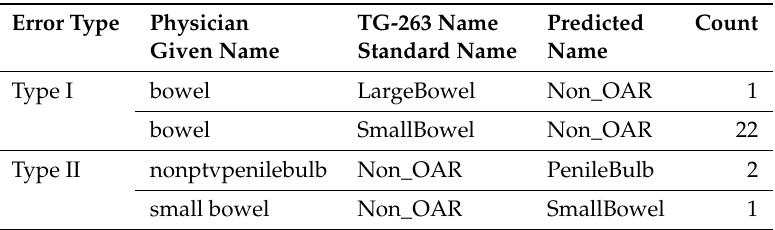
Table 6. Error analysis of VCU dataset prostate structure.